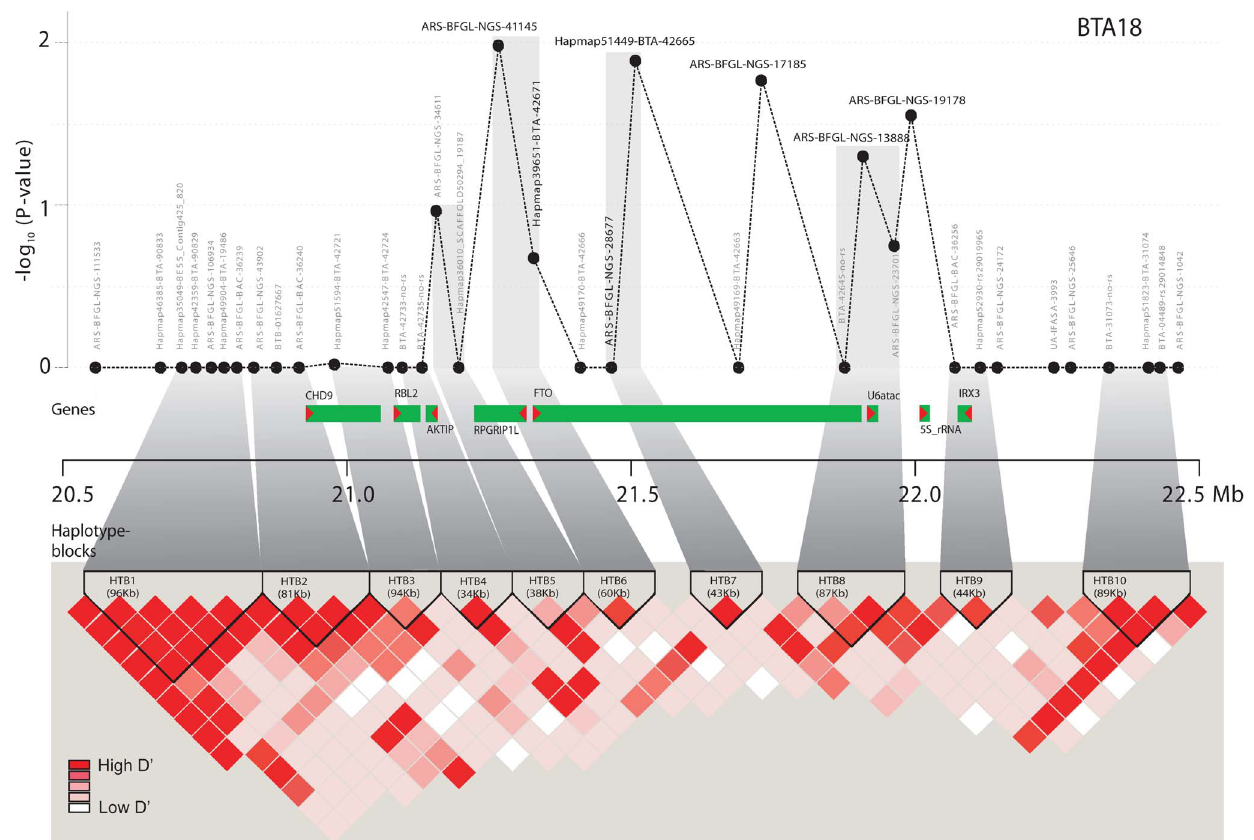
Figure 1. Gene and haplotype block structure of the 2 Mb FTO region and LD heat map. In the upper part, negative log 10 p-values of the regression model 4 (Table 1) are shown for SNPs within the 2 Mb target region of FTO. All genes of the region are highlighted in dark grey, with an arrow head pointing in the direction of transcription. The lower part shows the pairwise D’ for the FTO region calculated with H APLOVIEW . Haplotype blocks are indicated with black triangles.